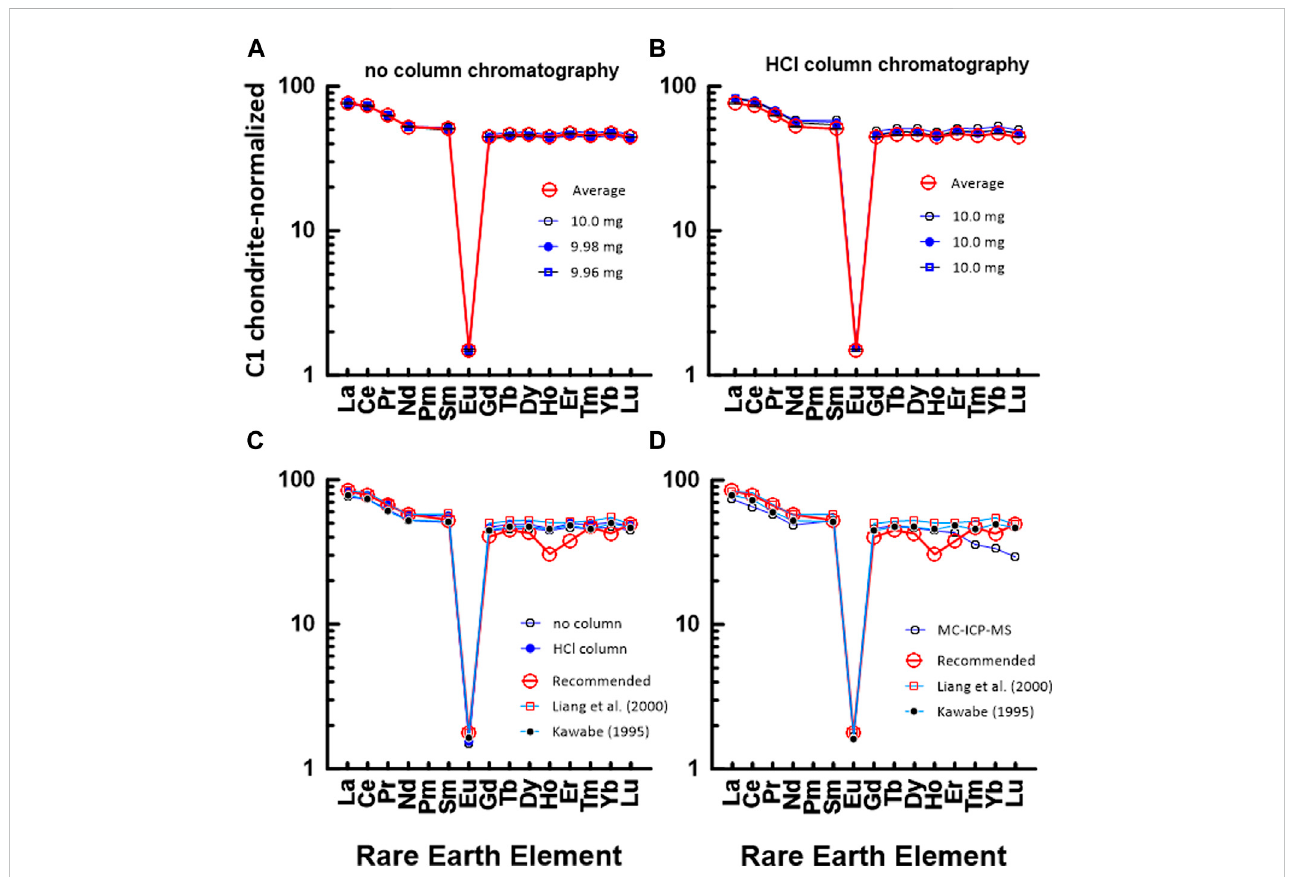
FIGURE 6 C1 chondrite-normalized REE patterns of JG2: (A) measured by conventional ICP-MS method without HCl column chromatography in this study and (B) measured by conventional ICP-MS method after HCl column chromatography in this study. The numbers in (A) indicate the gravity weight of sample. (C) comparison with the data measured by ICP-MS in this study and recommended value by GSJ, (D) comparison with the data measured by ICP-MS in this study and recommended value by